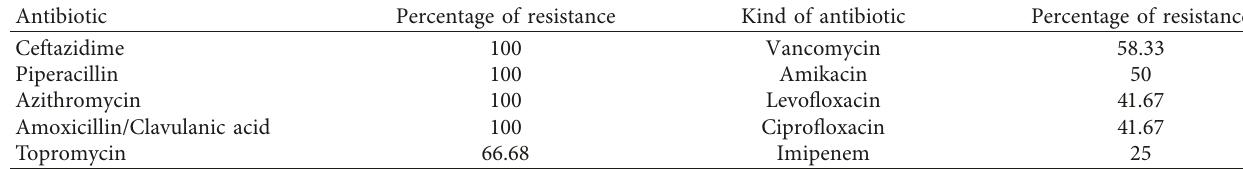
Table 4: The percentage of antibiotic resistance of virulent S. aureus isolates was detected by the diffusion method.